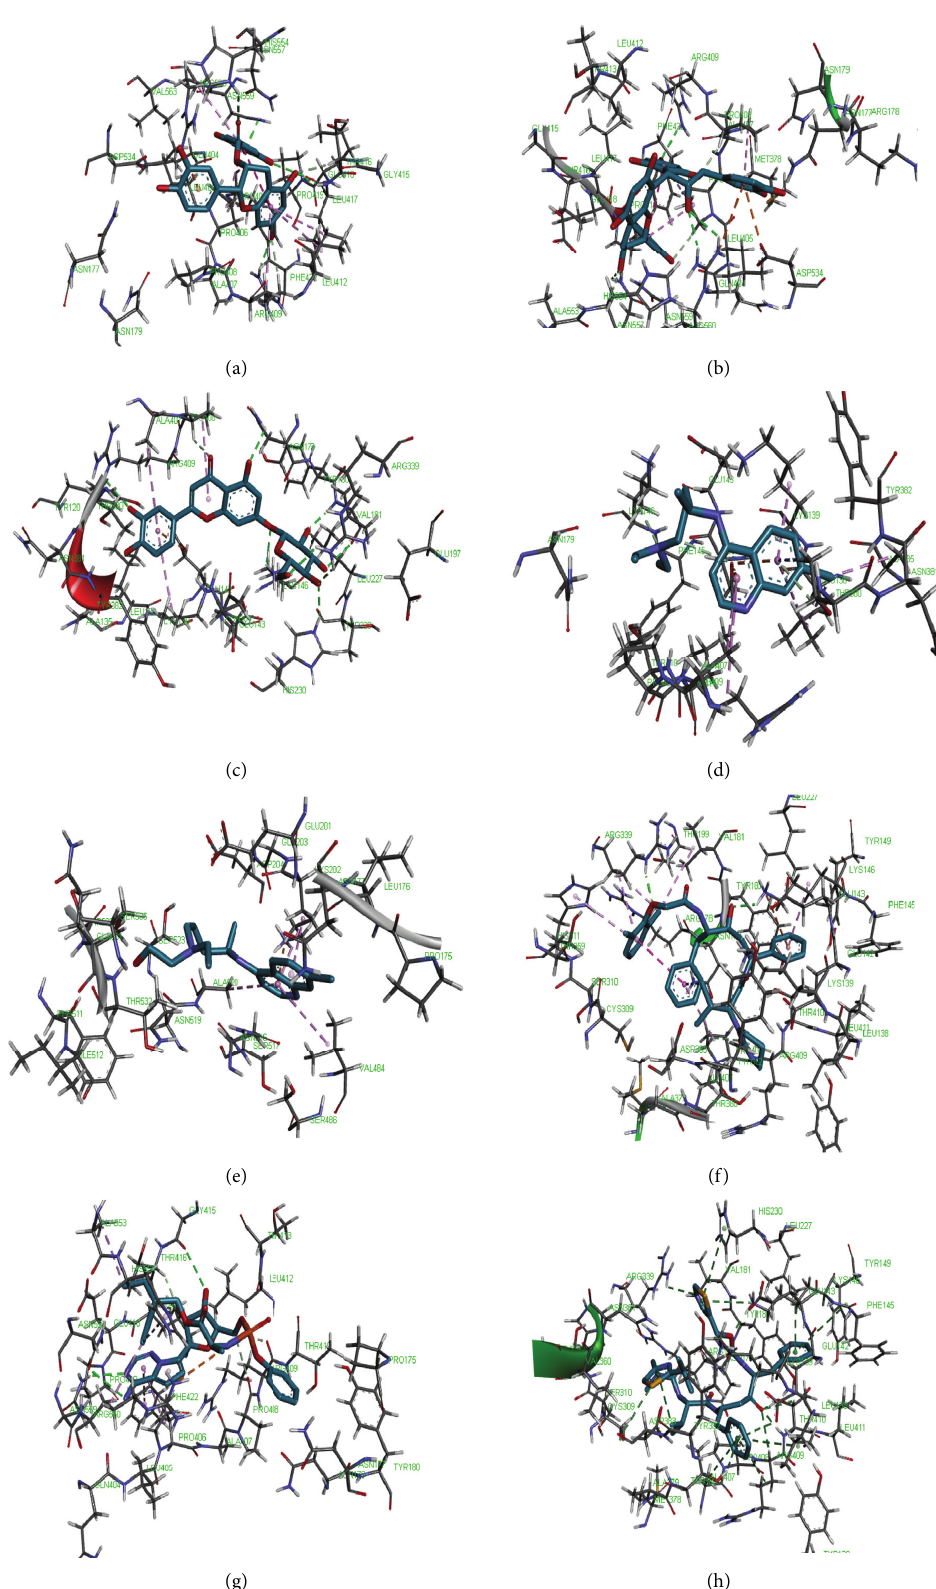
Figure 6: 3D representation of (a) 3-galloylcatechin, (b) proanthocyanidin B1, (c) luteolin 7-galactoside, (d) chloroquine, (e) hydrox- ychloroquine, (f) lopinavir, (g) remdesivir, and (h) ritonavir in the binding pocket of